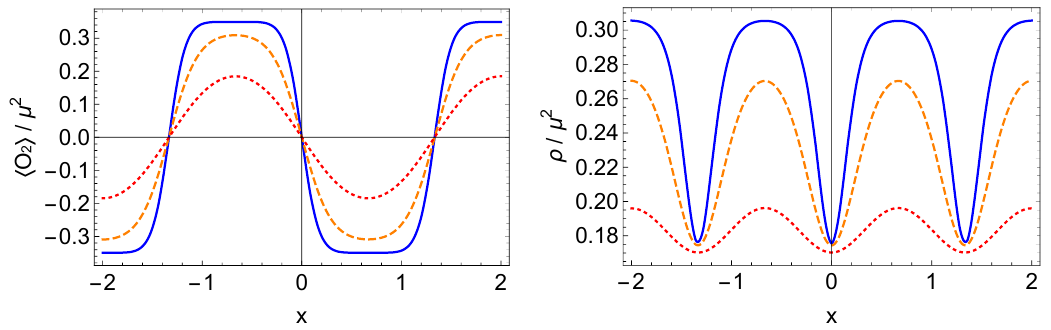
Figure 6 . The condensate (left) and the charge density (right) pro(cid:12)les obtained from each bulk solution with three nodes for (cid:22) = 20 (solid line), (cid:22) = 12 (dashed line), and (cid:22) = 7 (dotted line), respectively.